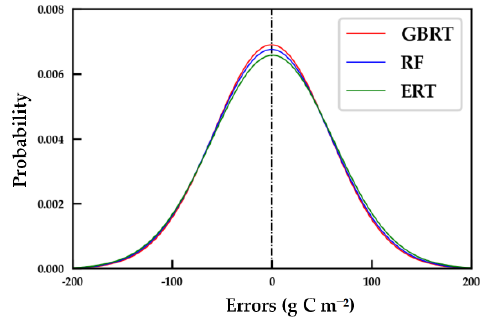
Figure 13. Probability density distributions of the predictive errors of MODIS-derived reference and AVHRR-derived estimated AGB in three AGB upscaling models, respectively.